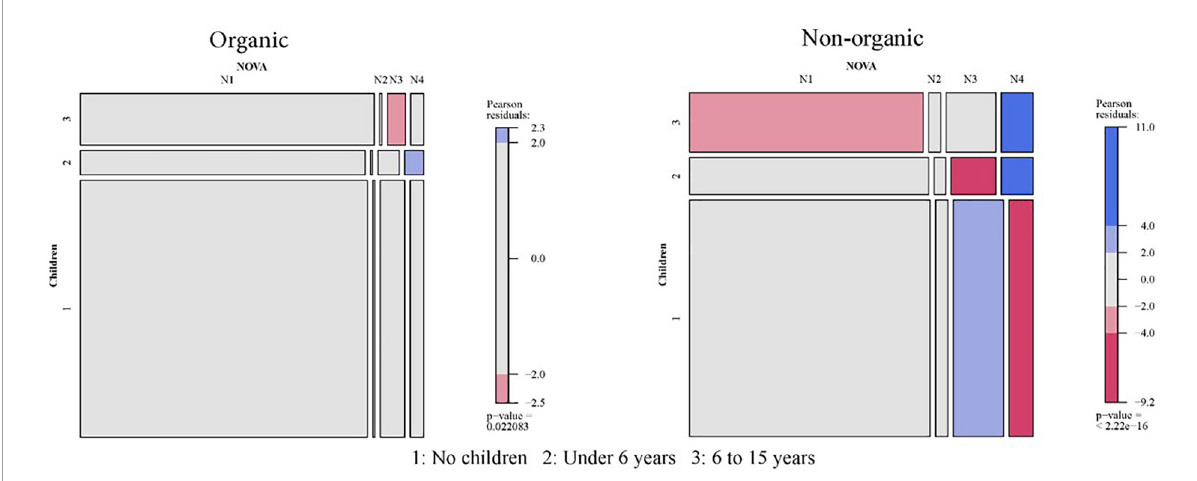
FIGURE6 Relationship between the presence of children in the household and NOVA: Organic vs. non-organic food purchases. 1: No children; 2: Under 6 years; 3: 6–15 years.